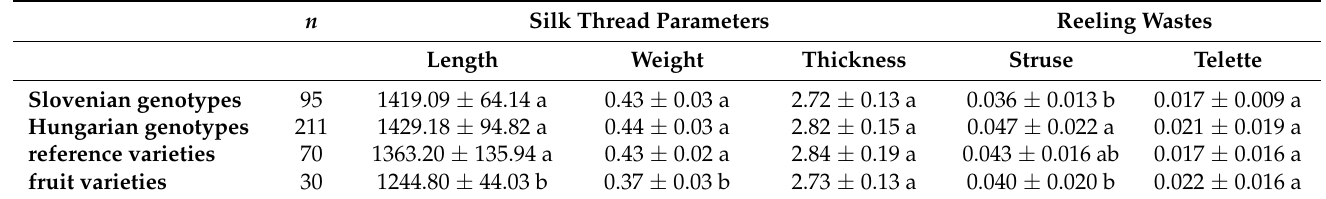
Table 4. Mean ( ± SD) raw silk and reeling waste parameters (g) of Slovenian, Hungarian mulberry varieties, reference sericultural varieties, and fruit varieties. Different letters (a, b) indicate significant differences ( p < 0.05), which were determined using the post hoc Duncan test. n , number of